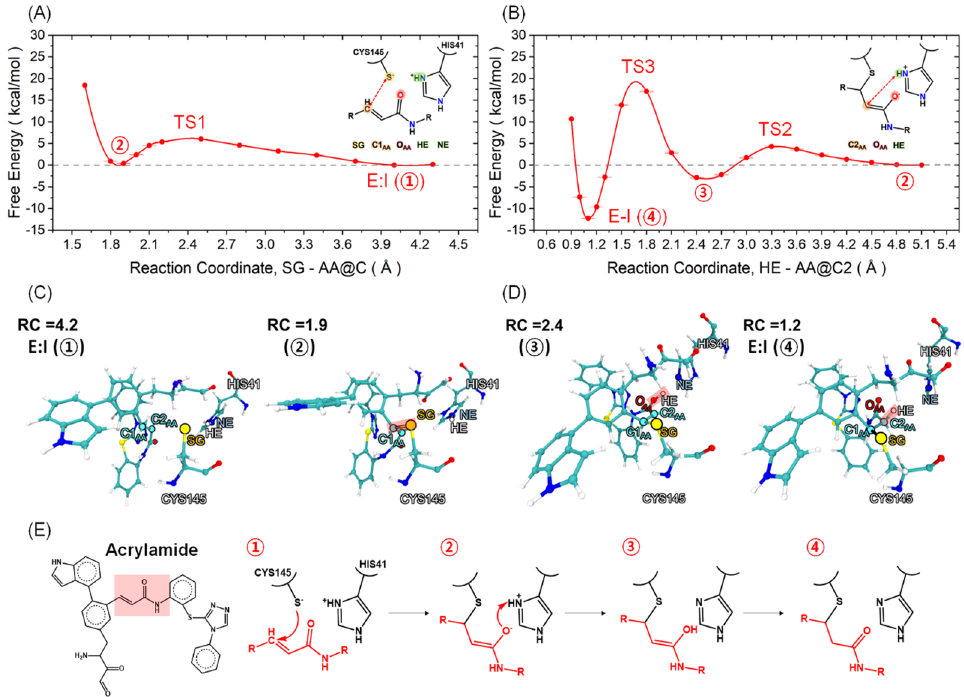
Figure 7. Free energy profile of the acrylamide inhibitor along the reaction coordinate, ( A ) distance between a SG atom of CYS145 and a C1 AA atom of acrylamide and ( B ) distance between a HE atom of HIS41 and C2 AA atom of acrylamide inhibitor . Representative snapshots were taken at different points of the reaction coordinate: highlighting ( C ) E:I formation ( ① ), and the tetrahedral intermediate ( ② ); ( D ) Second intermediate with a protonated oxygen atom ( ③ ), E-I complex ( ④ ) of the acrylamide inhibitor in M PRO . A proposed stepwise reaction mechanism from the E:I state to E-I complex of the acrylamide